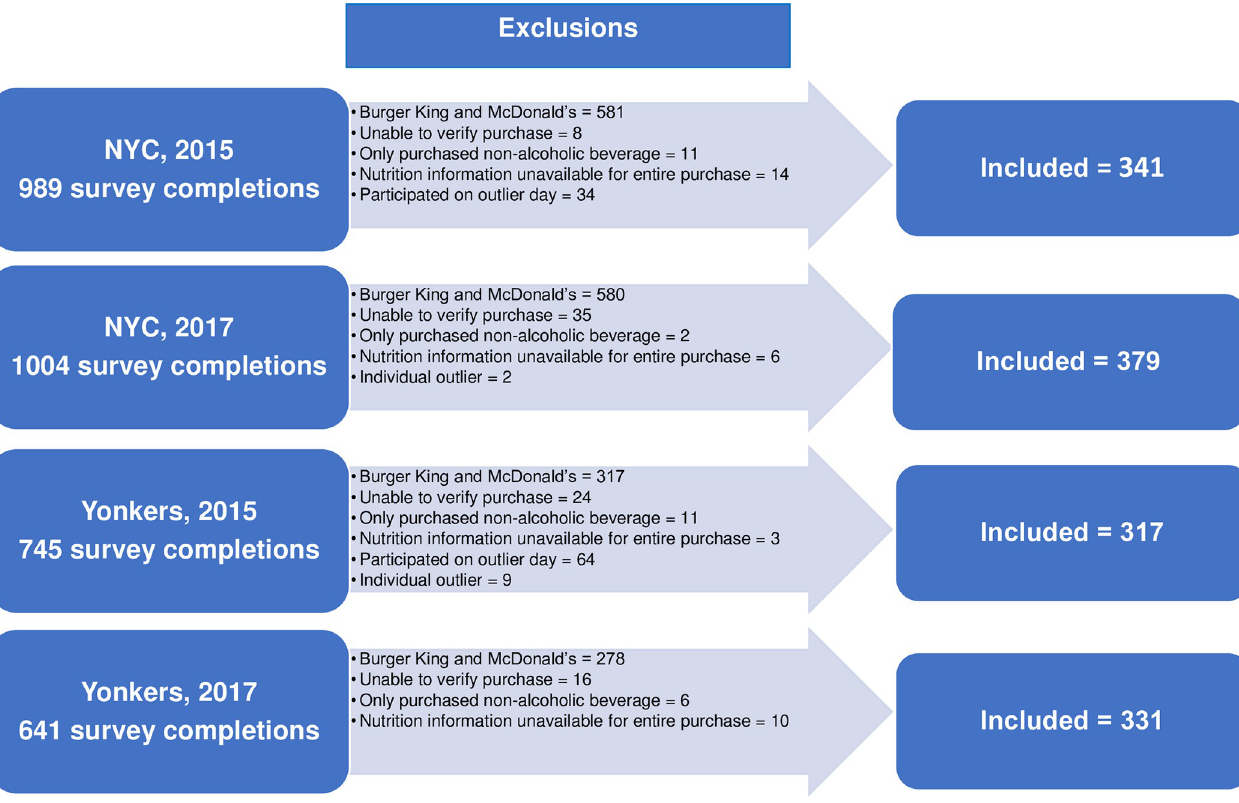
Fig 2. Participant flow chart, quick-service